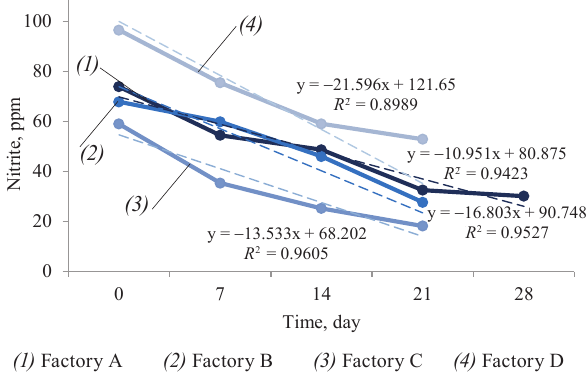
Figure 4 Correlation between residual nitrite content and nitrosamine in beef salami (90% meat)